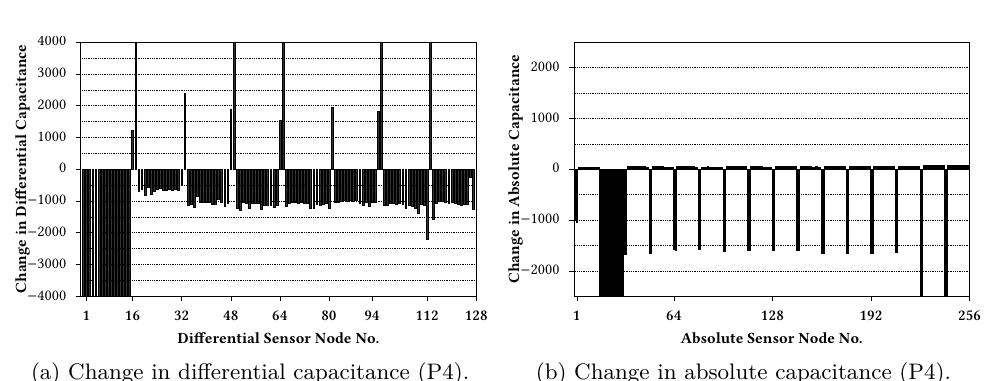
Figure 20: Attack Profile 4: attack with a single hole of diameter 0 . 33 mm and symmetric Rx cut-off. Here, severing electrodes Tx2, Rx1, and Rx2. attack. Taking the results of this attack and previous attack profiles into account, it is